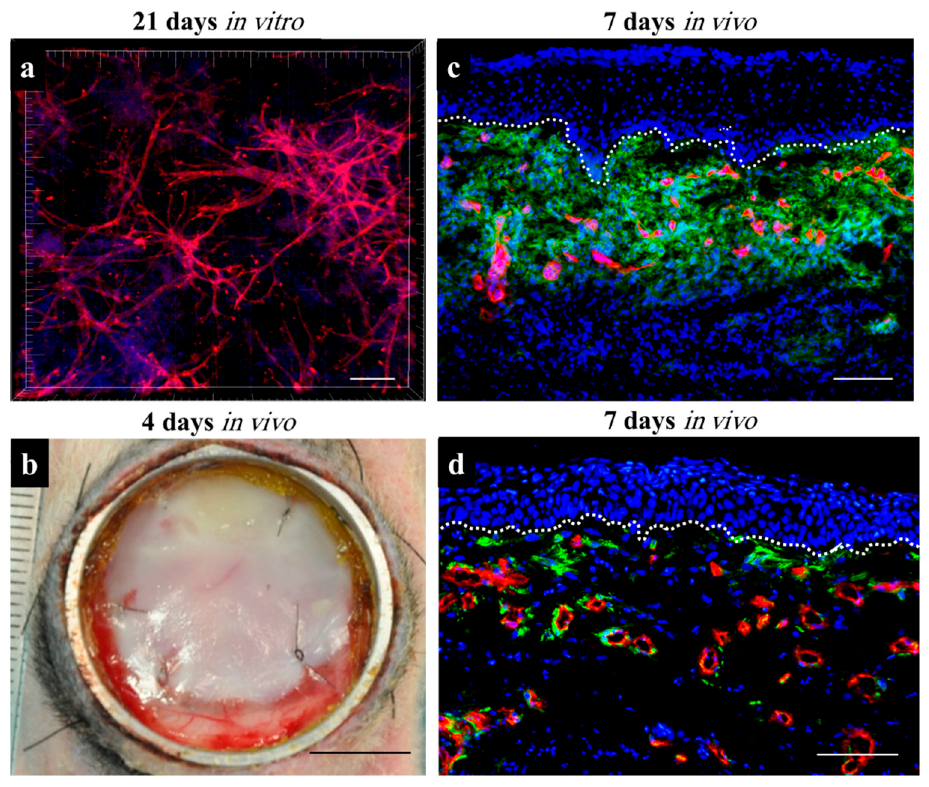
Figure 2. ( a ) A collagen type I hydrogel containing human adipose-derived microvascular networks cultured for 21 days in vitro, ( b ) A pre-vascularized bioengineered human dermo-epidermal skin substitute 7 days after transplantation onto the back of nu/nu rat, ( c ) Human engineered capillaries are visualized by the human-specific CD31-antibody (red) present in the CD90-positive (green) human neo-dermis. ( d ) Human CD31-capillaries (red) co-stained by human/rat alpha smooth muscle actin ( α SMA) (pericyte marker; green). HoechstI stains the nuclei in blue. White dotted line indicates the dermo-epidermal junction. Scale bar = 100 µm ( a – d ) and 1 cm ( b ) [12,20].